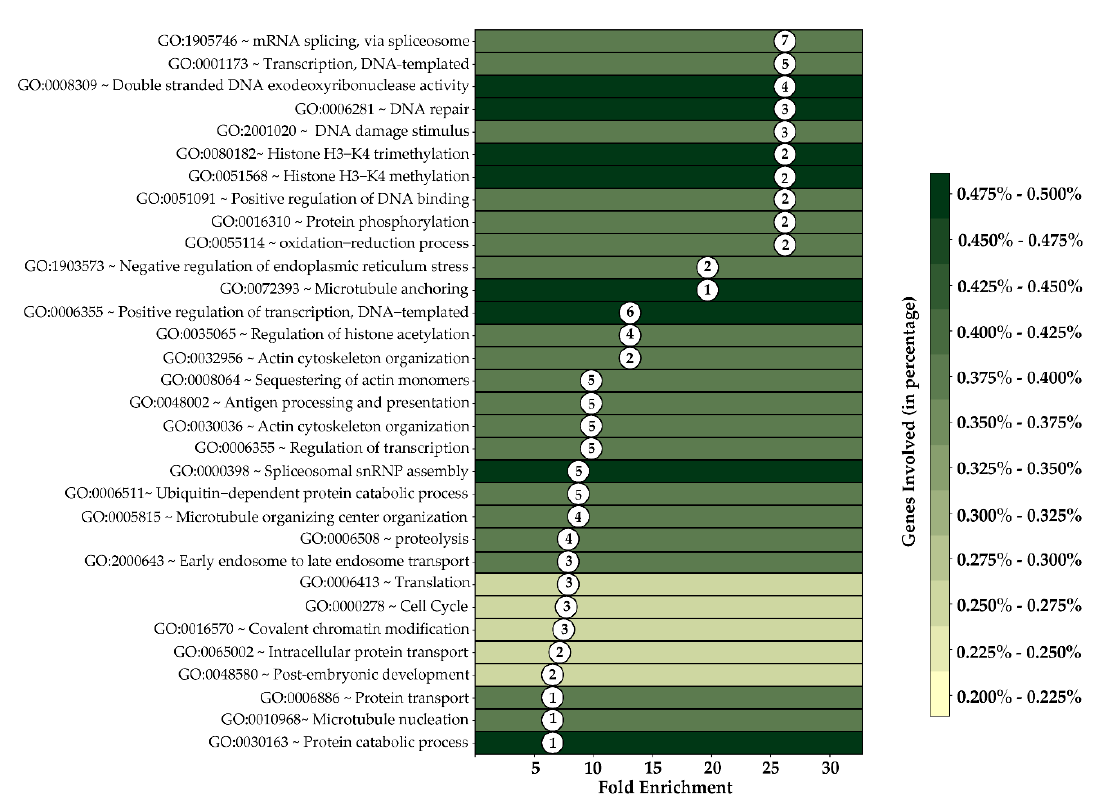
Figure 8. Gene function association by gene ontology (GO) analysis with DAVID in combination treatment group. Y -axis represents multiple cellular pathways associated with combination treatment group, and X -axis represents fold enrichments. Each GO term comprises the total number of significant DMGs that were described in circles inside the plot. Color code is based on the total number of individual GO terms estimated in